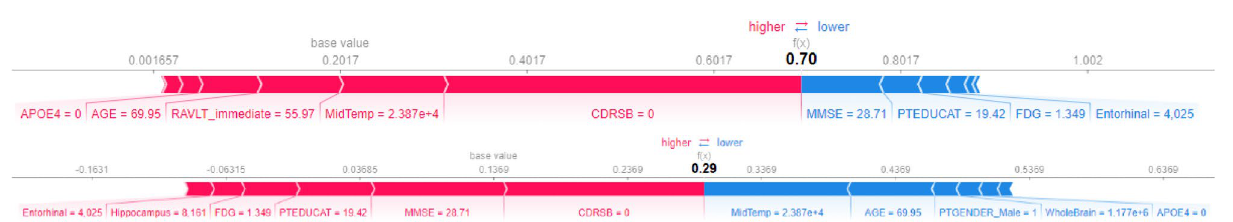
Figure 22. Comparison between features impact on the predicted (CN) and true class (SMC) of a subject.